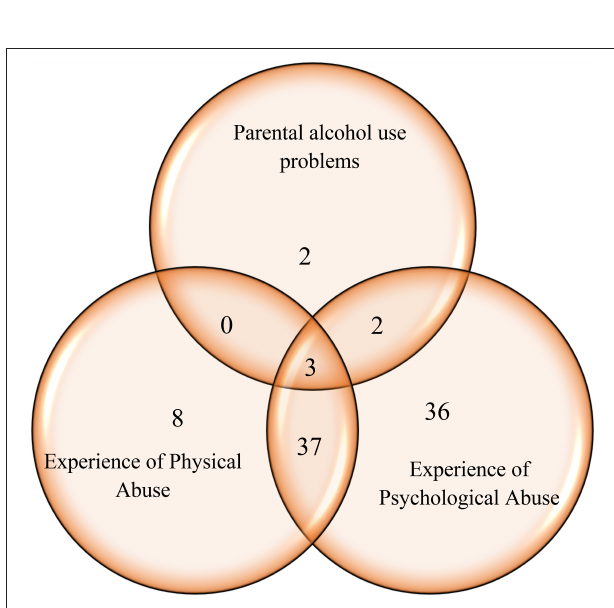
FIGURE 3 | The prevalence of female students reporting the existence of different negative psychosocial problems in a sample of Swedish high school students ( n =